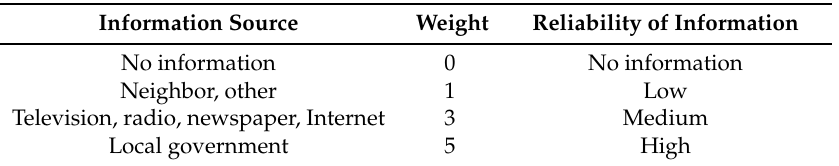
Table 4. Reliability of information